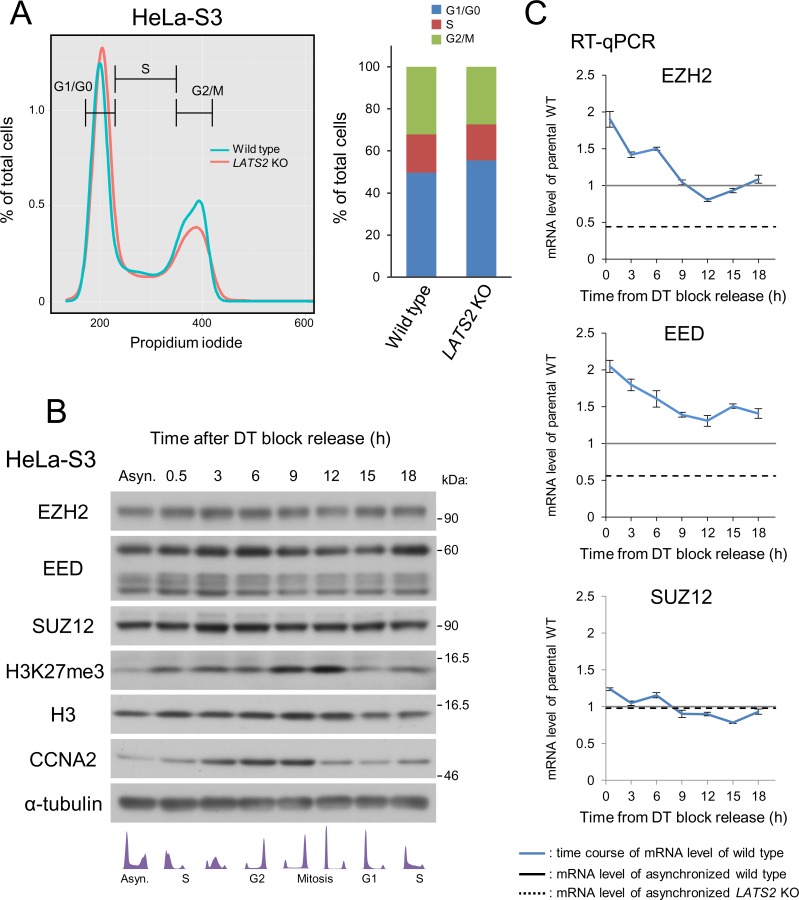
Downregulation of PRC2 upon LATS2 KO is not due to cell cycle aberrations.(A) No differences in the cell cycle were observed in HeLa-S3 cells upon KO. Cell-cycle analysis by FACS showing that growing, asynchronous LATS2 KO HeLa-S3 cells do not exhibit retention at any stage of the cell cycle. (B) Western blotting of PRC2 components and the H3K27me3 mark in wild type HeLa-S3 cells throughout the cell cycle. α-tubulin and H3 were used as loading controls, and CCNA2 was used as a cell-cycle indicator. A portion of the cells was analyzed by FACS, and is depicted in the bottom panel. (C) RT-qPCR analysis of PRC2 components in wild type HeLa-S3 cells. Black line and dotted line indicate the expression level of each gene in asynchronous wild type and LATS2 KO HeLa-S3 cells, respectively. The expression levels of EZH2 and EED oscillate during the cell cycle but do not reach the level attained in LATS2 KO cells. Each transcript level was normalized against ACTB; Error bars show SD.